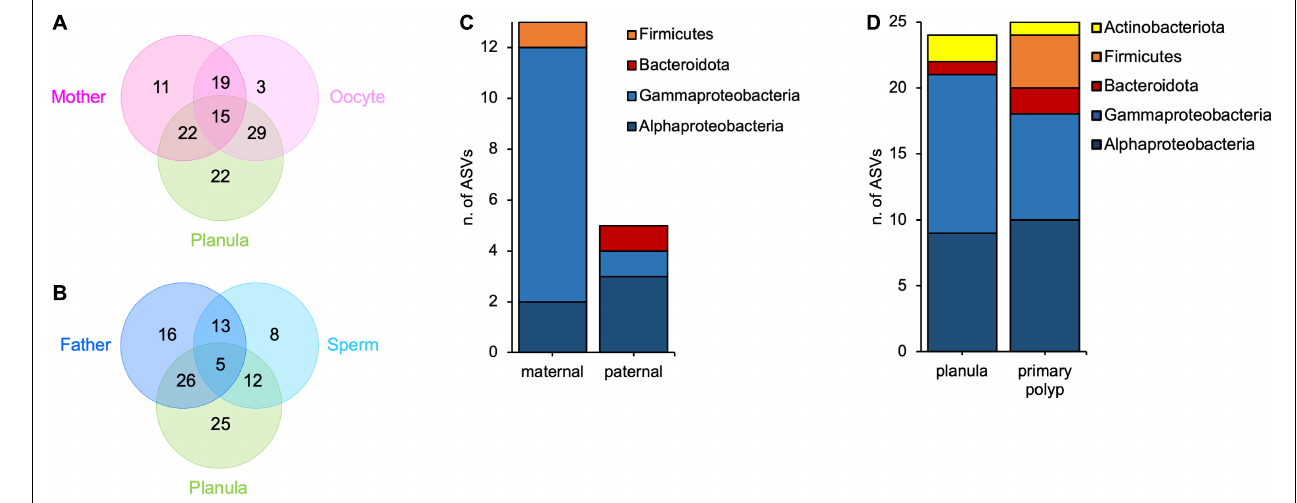
FIGURE 3 | Vertical and horizontal contributions to offspring microbiota. (A) Venn diagram showing the number of ASVs shared between mothers, oocytes and planulae; (B) Venn diagram showing the number of ASVs shared between fathers, sperms and planulae; (C) Bar-chart of parentally transmitted bacterial ASVs divided by major groups; (D) Bar-chart of environmentally transmitted bacterial ASVs divided by major